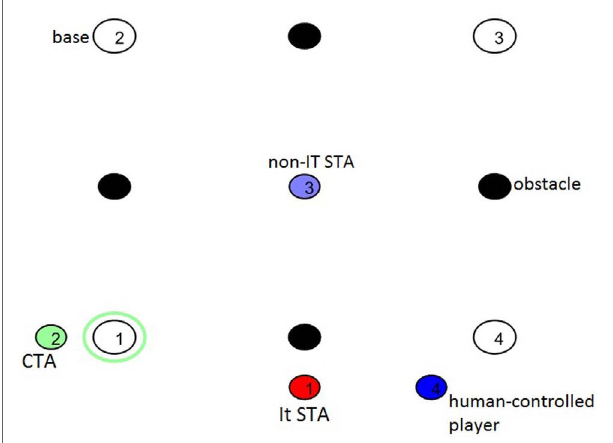
FIGURE 10 | Simulated interactive Tag game . The screenshot (with added labels) illustrates field layout and Tag players. Elements include bases, obstacles, human-controlled players, It agents, cognitive Tag agents, and simple Tag agents. [Aaron et al. (2011) contain additional details about these Tag simulations.]